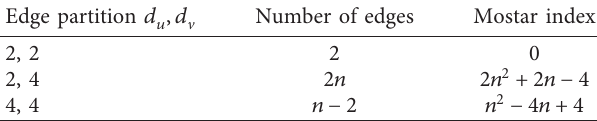
Table 5: Edge partition of oxide network of even order. Edge partition d u , d v Number of edges Mostar index